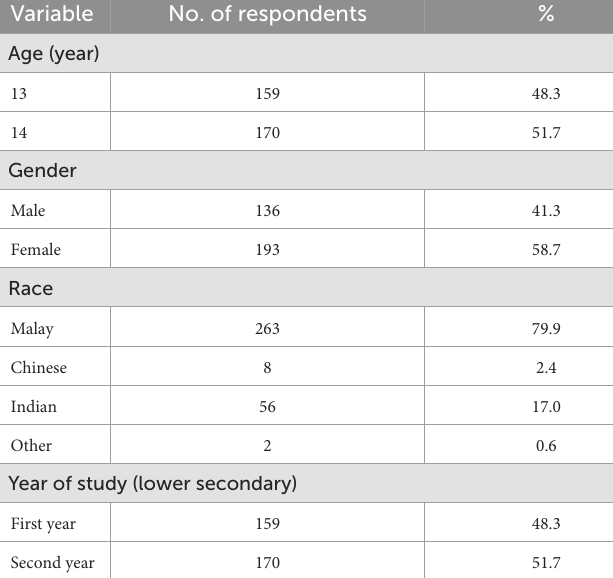
TABLE 1 Socio-demographic of 329 respondents. TABLE 2 Factor loading and communality for the single-factor solution for